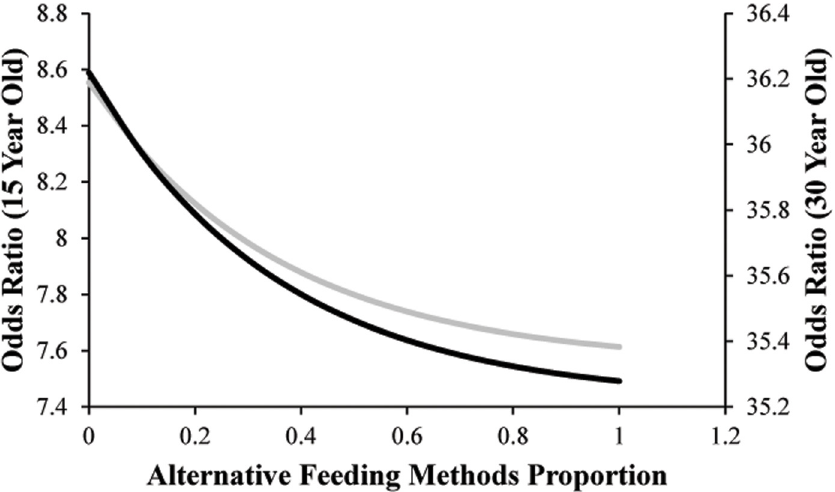
Fig 4. Odds of hyperprolactinemia for a 15-year-old (grey) and a 30-year-old (black) elephant with average Enrichment Diversity and Social Group Contact decreases as Alternative Feeding Methods proportion increases. See Meehan et al. [45] and Greco et al. [47] for variable definitions and